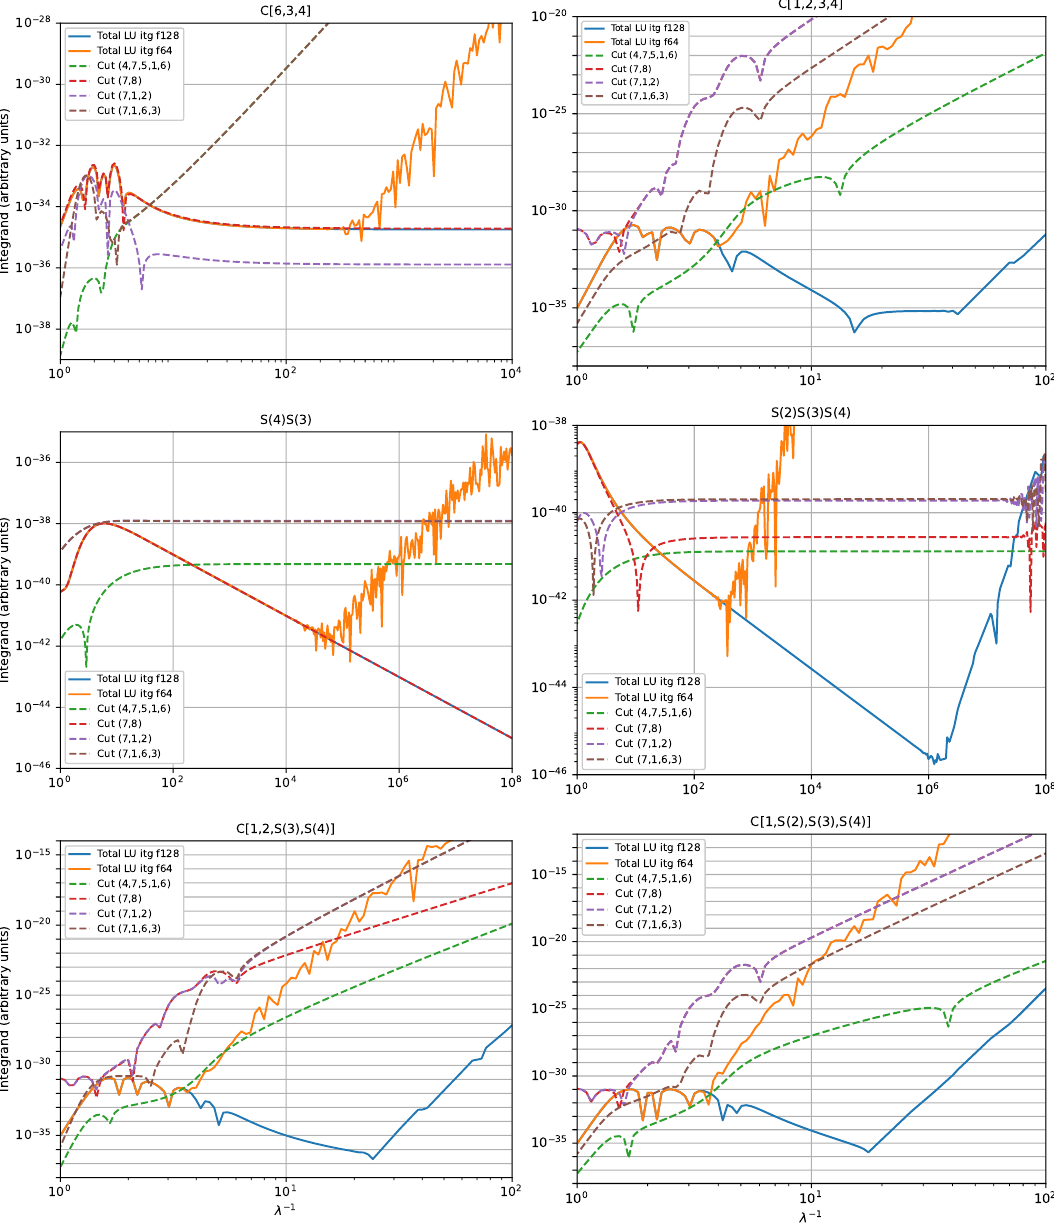
Figure 16. Behaviour of the LU integrand of supergraph H.3 of eq. (6.6) for various collinear, soft and soft-collinear limits approached using a rescaling parameter λ as shown in eq. (B.1). The soft scaling of the measure, i.e. d~p , is included in the lines shown for each momentum 3 d~p i → λ i approaching a soft limit, but our paramaterisation does not reflect the collinear suppression in the measure proportional to cos( θ ) . Dashed lines correspond to the LU integrand for each of the four ij Cutkosky cuts of supergraph H.3, whereas the solid blue, resp. orange, line corresponds to the sum of all cut contributions evaluated using quadruple precision (f128) arithmetics, resp. double precision (f64)